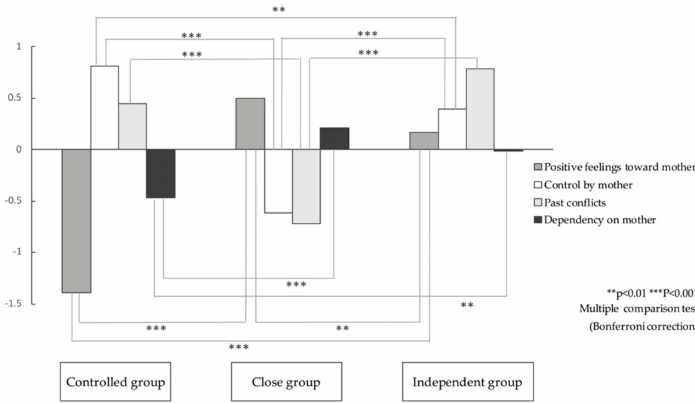
Figure 1. Mother-daughter relationship scale: cluster analysis results ( n = 329).